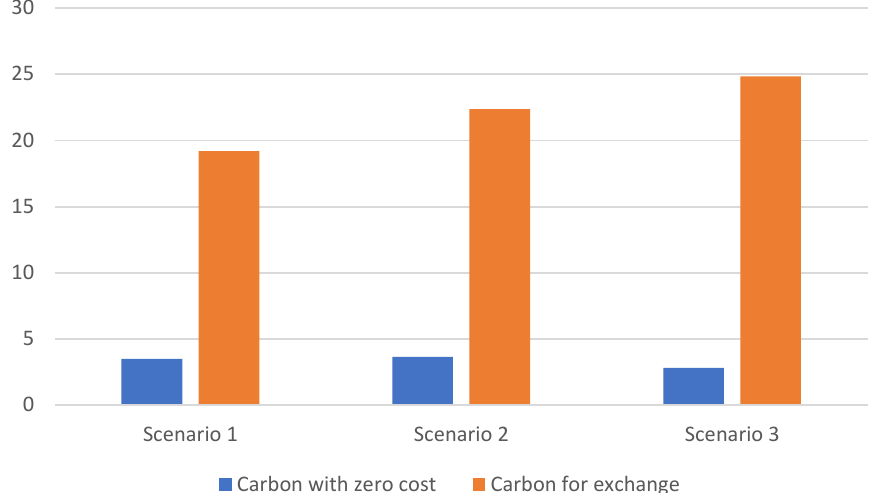
Figure 9. A comparison of the results of three scenarios.